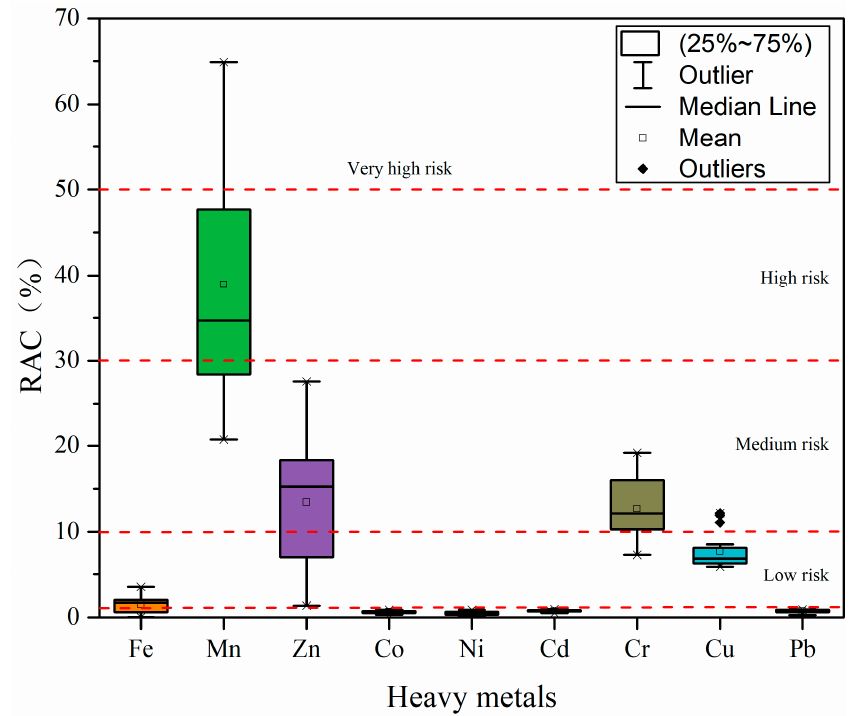
Figure 7. Risk assessment code ( RAC ) values of heavy metals in surface sediments from the Qinjiang River.